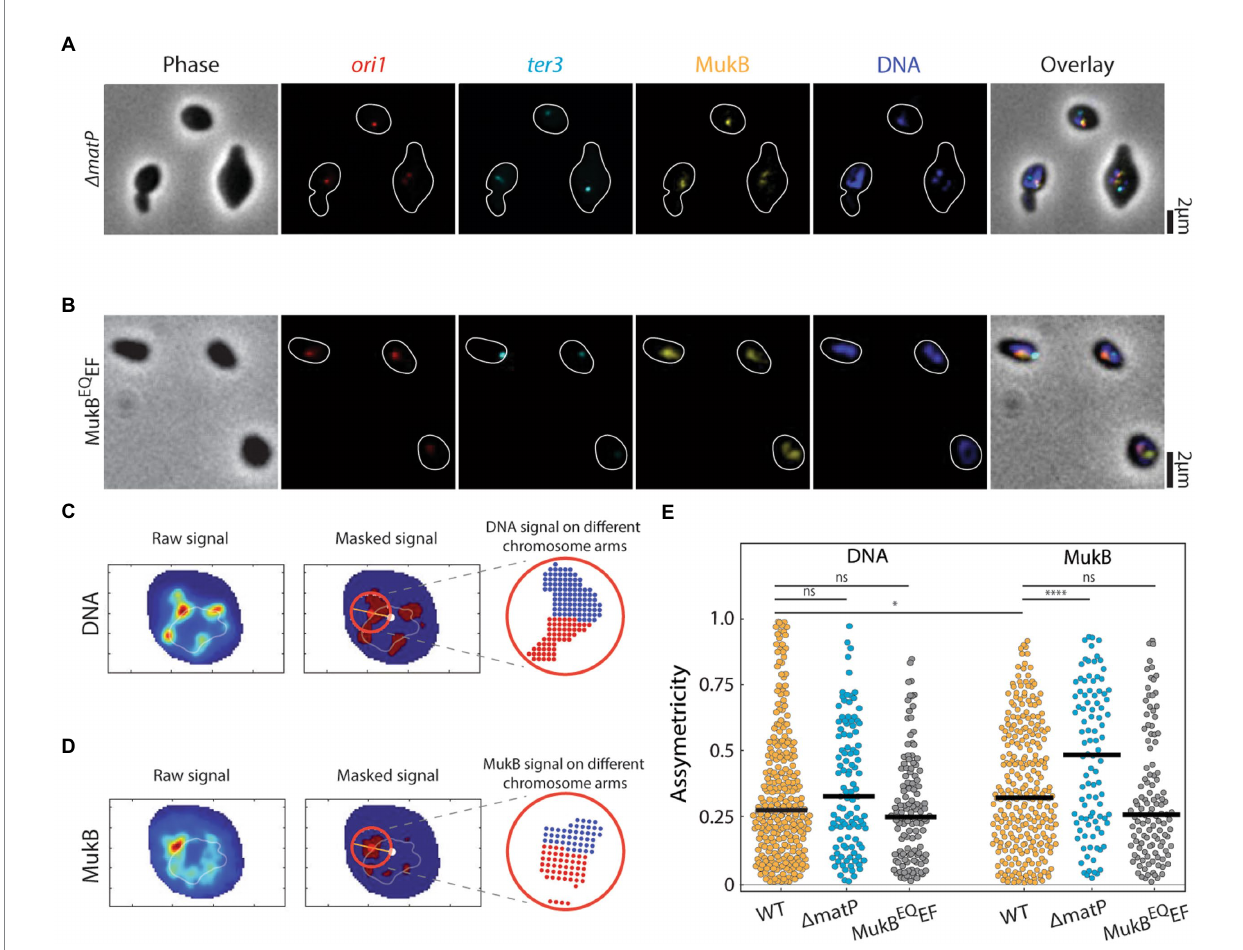
FIGURE 2 Asymmetric spreading of MukB complexes along the right and left arms of the chromosome. Representative images of (A) Δ matP , (B) MukB EQ EF E. coli cells in phase contrast and the fluorescence channels of ori1 (red), ter3 (cyan), MukB (yellow), DNA stained with DAPI (blue) and their overlay. Cell outline is indicated in white. Measuring the local spreading of (C) DNA, and (D) MukB near the origin of replication. Left: the central ridge of the fluorescent signal is determined. Middle: the central axis (orange line) is detected along the origin (red spot) to the chromosome center of mass (white spot). Only for the circular area (red circle) around the origin, asymmetricity is determined. Right: a symmetry value is defined as the difference in signal from anticlockwise area (blue) and clockwise area (red) (relative to the line connecting ori and the center of mass) divided by their sum signal. Orange and light blue colors denote high and low signal intensity, respectively. (E) Asymmetricity distributions for DNA and MukB channels as defined in panels c and d for wildtype ( N = 284 cells), Δ matP ( N = 108 cells), and MukB EQ EF mutants ( N = 124 cells). Horizontal black lines represent median